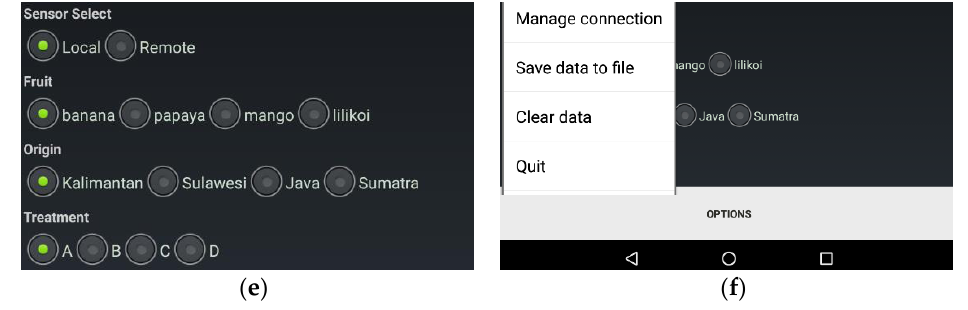
Figure 2. Illustration of ABE-VIEW graphical interface with customizable elements including: ( a ) interactive chart; ( b ) up to 16 data fields with text headings; ( c ) up to 8 buttons; ( d ) up to 8 numerical controls with customizable range and resolution; ( e ) up to 4 radio groups with up to 4 radio buttons each, and; ( f ) options menu while connected to remote instrument. All elements between the chart and options button are contained in a scrollview to ensure they are all accessible to the user.